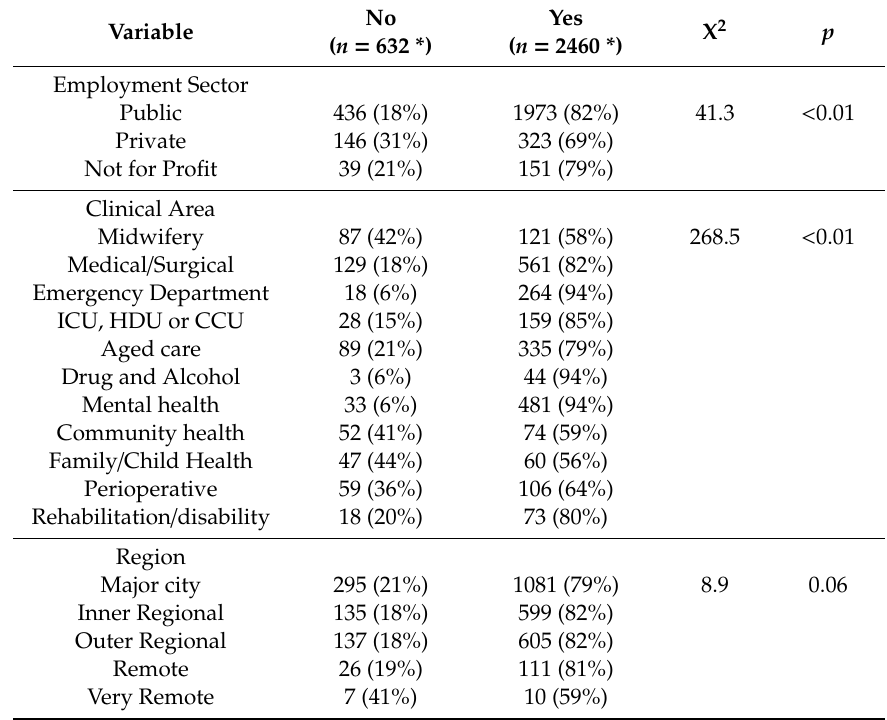
Table 3. Episodes of violence, by work sector and clinical area.